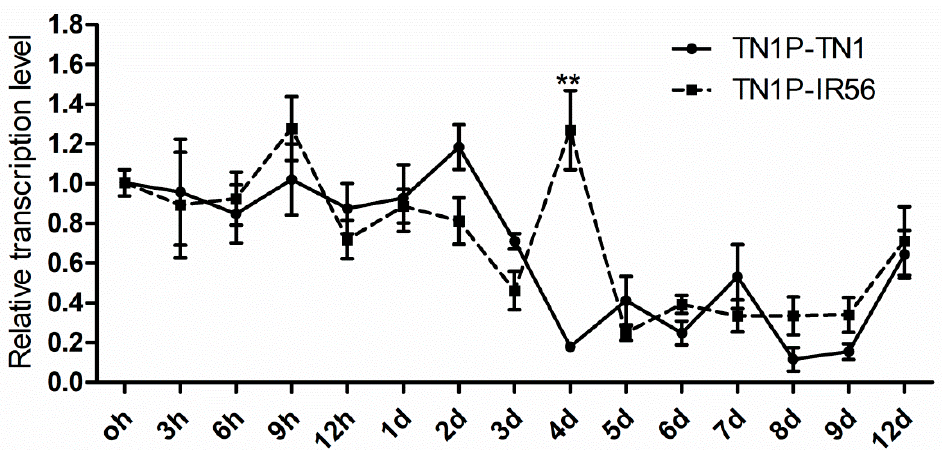
Figure 7. The transcription of NlCaMKII on the successive time of the TN1 population reared on two di ff erent rice varieties. Data are denoted as the mean ± standard error (SE) and analyzed by three-way ANOVA followed by Tukey’s honestly significant di ff erence test. The mRNA levels for each cDNA were normalized with respect to the 18s-rRNA mRNA level. Fold induction values of CaMKII genes were calculated with the ∆∆ C t equation and normalized to the mRNA level of CaMKII genes in the newly emerged TN1 population, which were defined as 1.0. ** indicates the statistical di ff erence by ANOVA followed by Duncan’s Multiple Comparison test ( p < 0.01). TN1P-TN1 indicates that the TN1 population fed on the Taichung Native1 rice variety; TN1P-IR56 indicates the TN1 population fed on the resistant rice variety IR56.